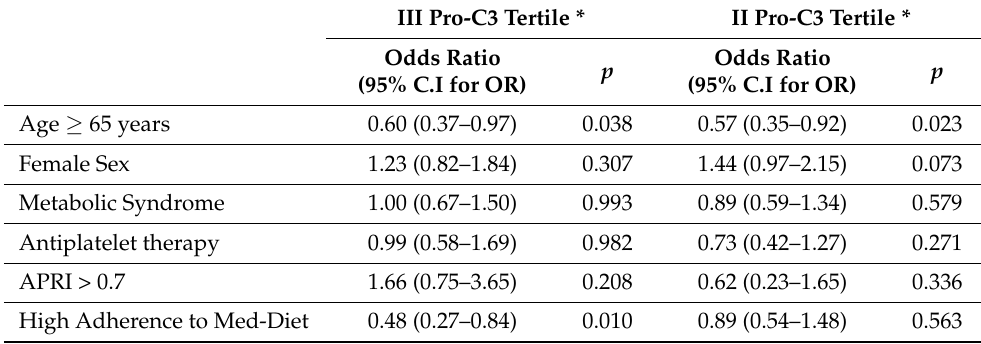
Table 5. Multivariate logistic regression analyses of factors associated with Pro-C3 tertiles. III Pro-C3 Tertile